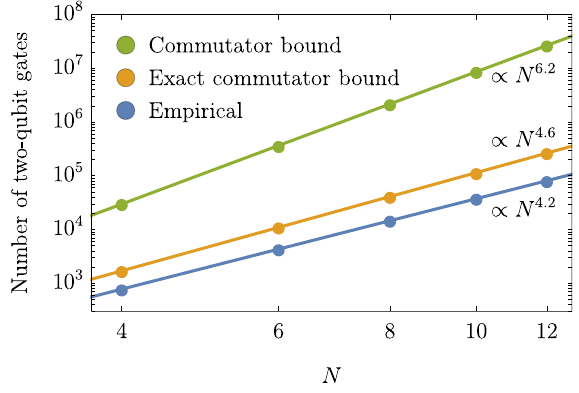
FIG. 2. The number of two-qubit gates required to simulate the time evolution under the Hamiltonian in Eq. (2) on an N -site lat- tice for time t = N given an error tolerance (cid:13) = 0.01, and using the second-order product formula in Eq. (8). The commutator bound on the gate complexity (green dots) is estimated from the error bound in Eq. (10). We also obtain a tighter estimate (orange dots) by exactly computing the nested commutators in Eq.